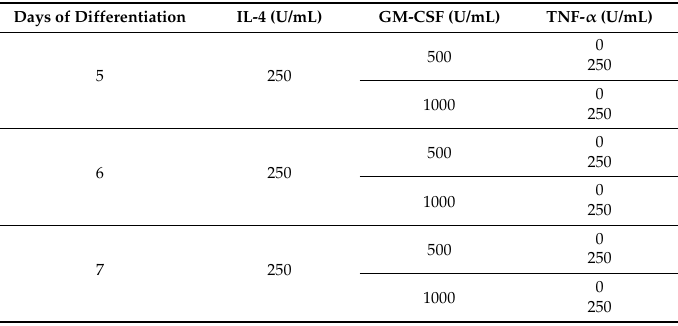
Table A1. Differentiation conditions for the MUTZ-3 cell